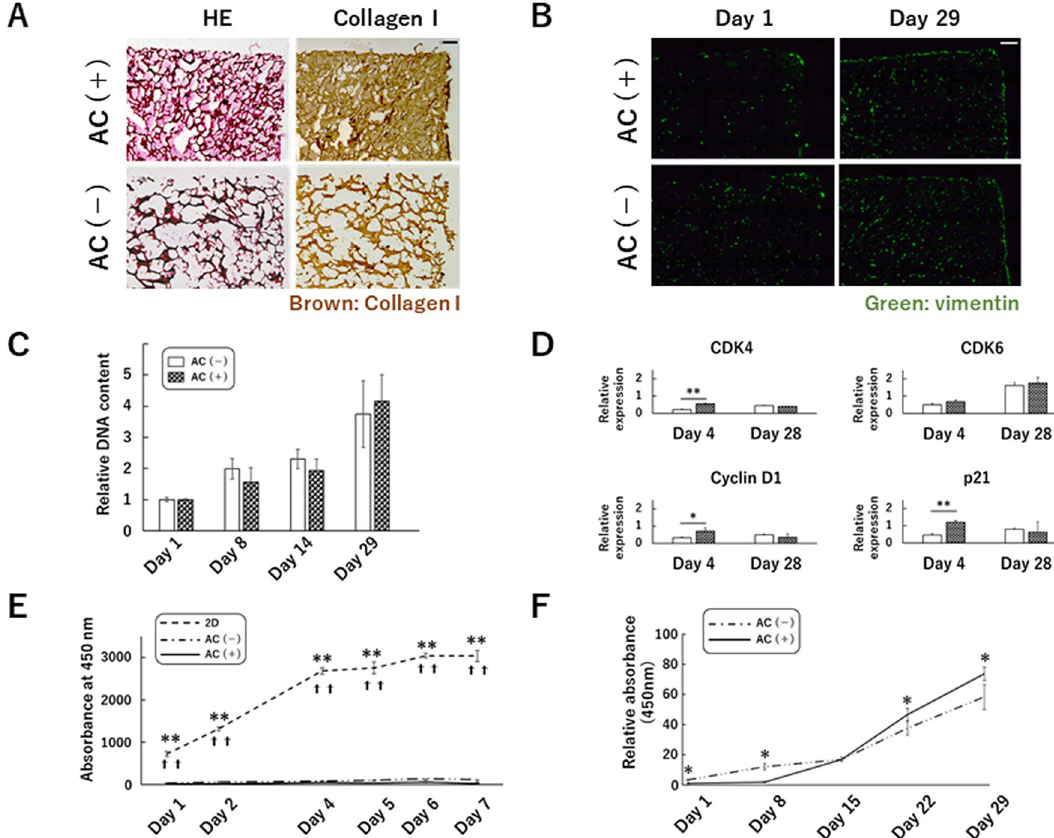
Figure 1. Effects of atelocollagen gel on human articular cartilage-derived chondrocytes in three-dimensional culture. ( A ) Semi-serial sections were stained with hematoxylin and eosin and immunostained with anti-type I collagen antibody. Atelocollagen gel (brown signal) is observed in the pores of the entire sponge (upper right panel). Scale bar: 200 μm. ( B ) Sections immunostained with anti-vimentin antibody. Green: Vimentin. Scale bar: 200 μm. ( C ) Changes in the amount of cellular DNA in the sponge over time. Total DNA content is measured on day1, 8, 14, and 29. Data are normalized to the values at day1. ( D ) Comparison of the expression of cell cycle-related factors. Normalized expression relative to 2D culture cells at approximately 50–60% confluency (semi-confluent monolayers) is shown. ( E , F ) The metabolic activity after seeding 5000 cells / well or sponge was evaluated over time by absolute absorbance using a Cell Counting Kit-8. ( E ) Comparison between 2D culture, AC(−), and AC(+) groups for 7 days. ** and ✝✝ denote statistically significant differences between 2D culture and AC(−) group or between 2D culture and AC(+) group ( p < 0.01), respectively. ( F ) Comparison between the AC(−) and AC(+) groups for 29 days. The relative absorbance is shown with the value in AC(+) on day 1